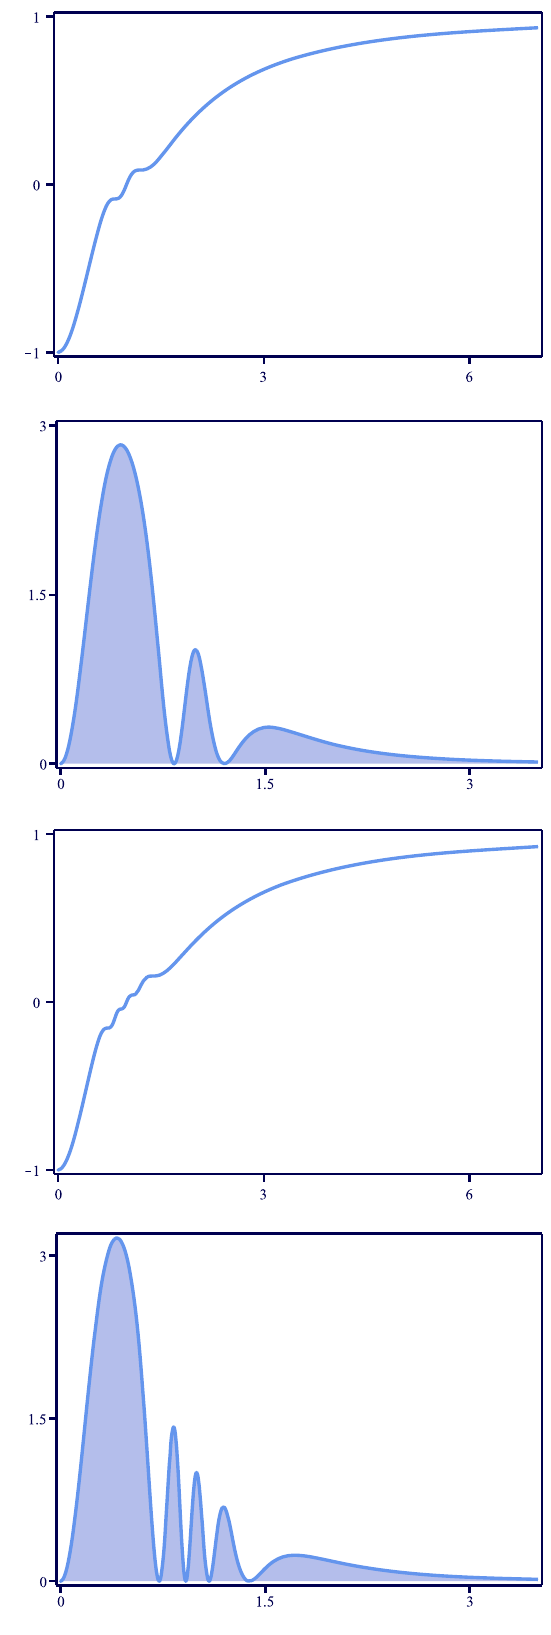
Fig. 5 The solution in Eq. (47) and its energy density (48) for α = 3 and for n = 1 (top and middle top) and 2 (middle bottom and